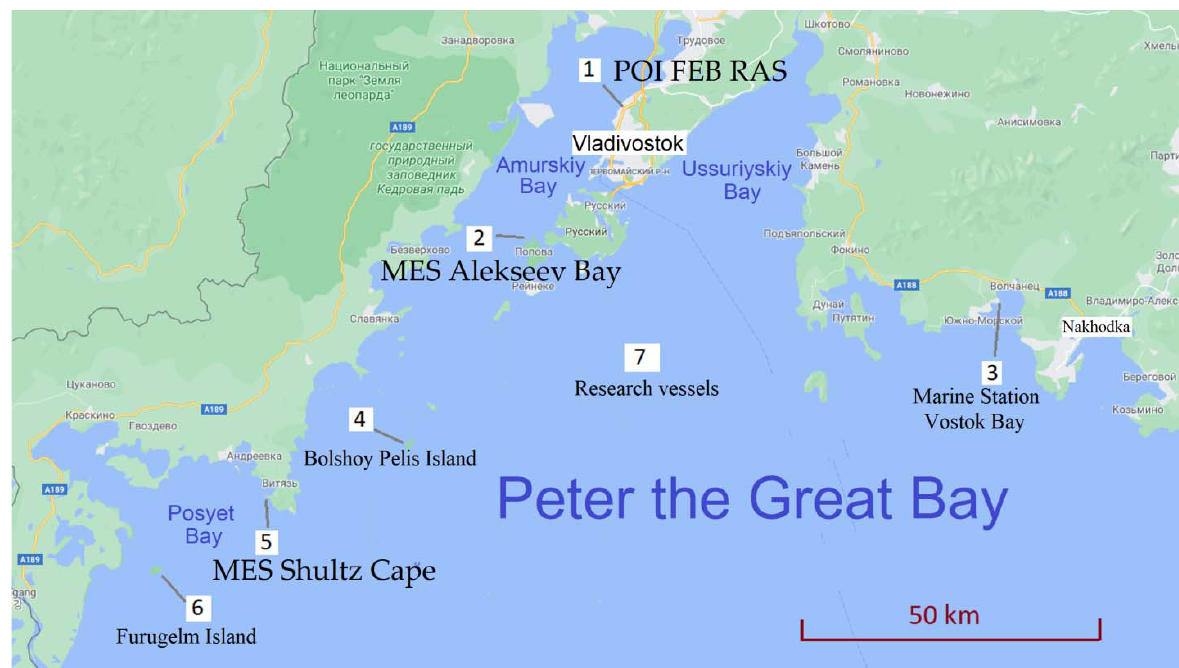
Figure 1. Locations of surface and underwater video surveillance camera installation (Google Map service